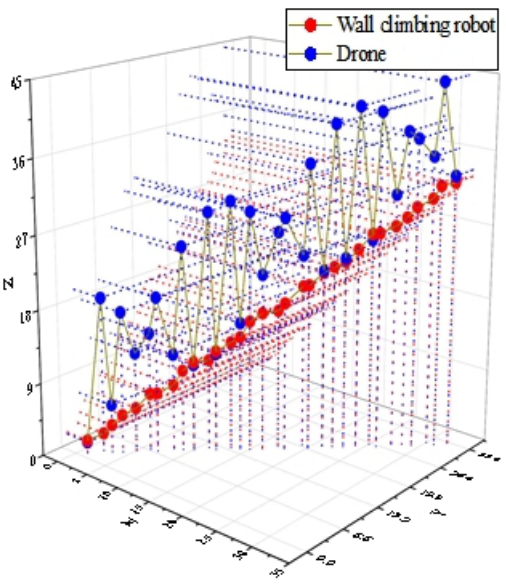
Fig. 7. Complex threats, planning renderings of the guidance method without road signs